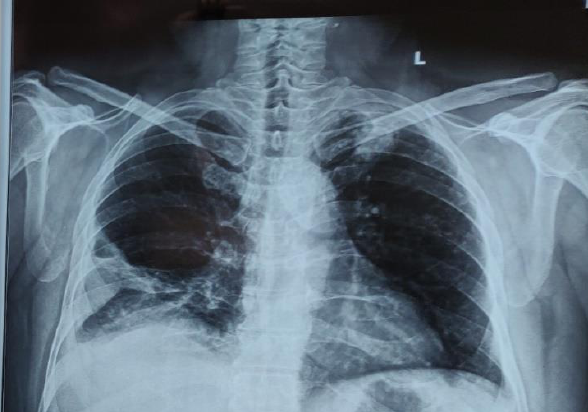
Figure 6. Chest x ray of the patient after 1 week of